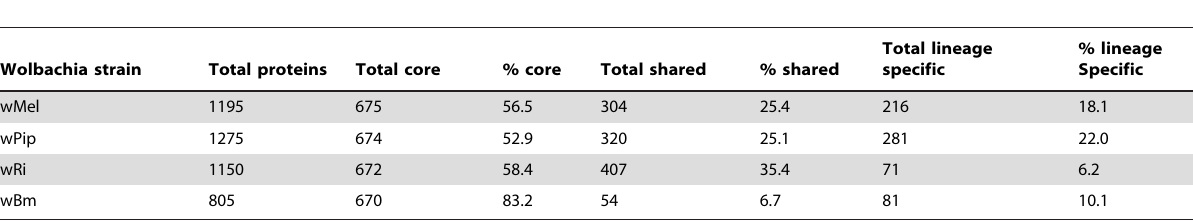
Table 3. Identification of core genome for Wolbachia strains with complete genome sequences using OrthoMCL a .